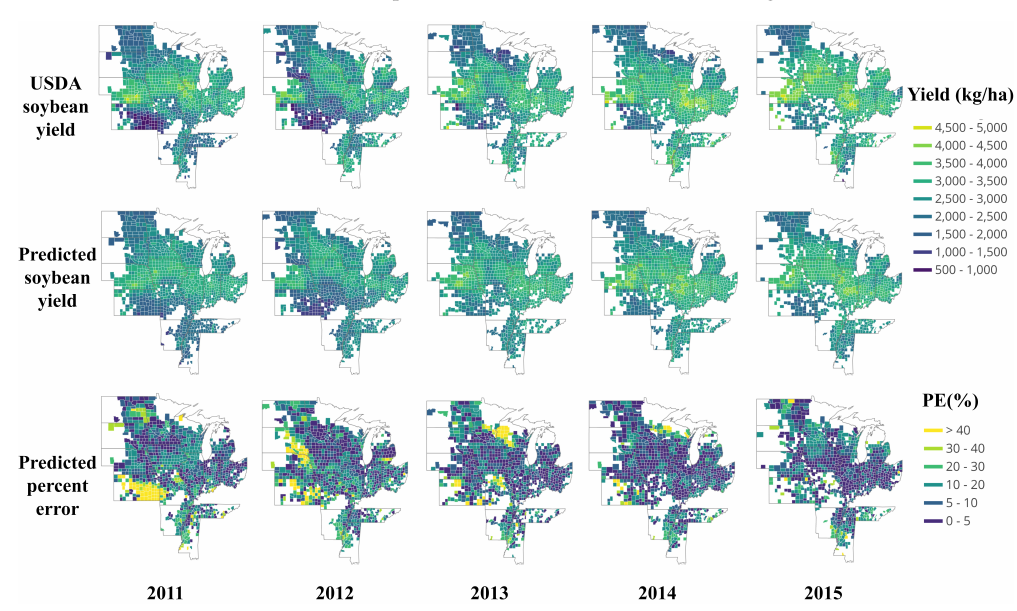
Figure A4. Map of USDA soybean yield, convolutional neural network (CNN) in-season predicted soybean yield and PE from 2011 to